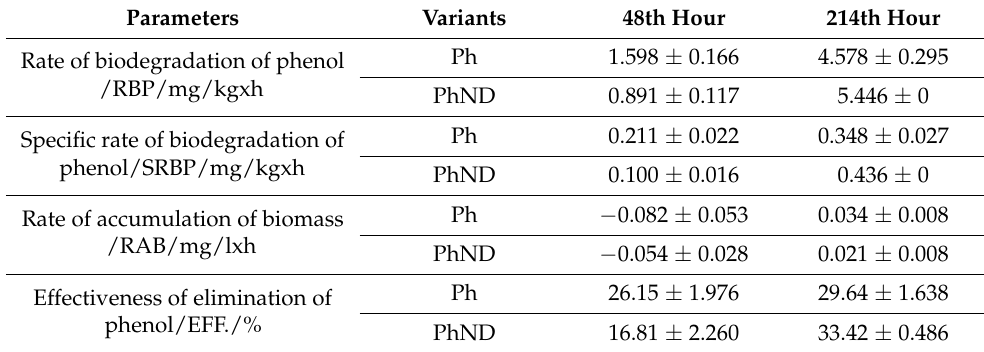
Table 2. Kinetic parameters of phenolic biodegradation and biomass growth.